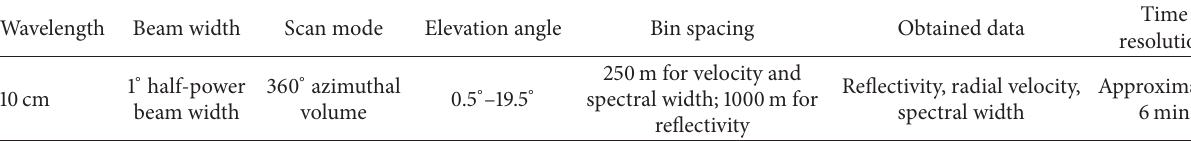
Table 1: Hefei CINRAD radar parameters.